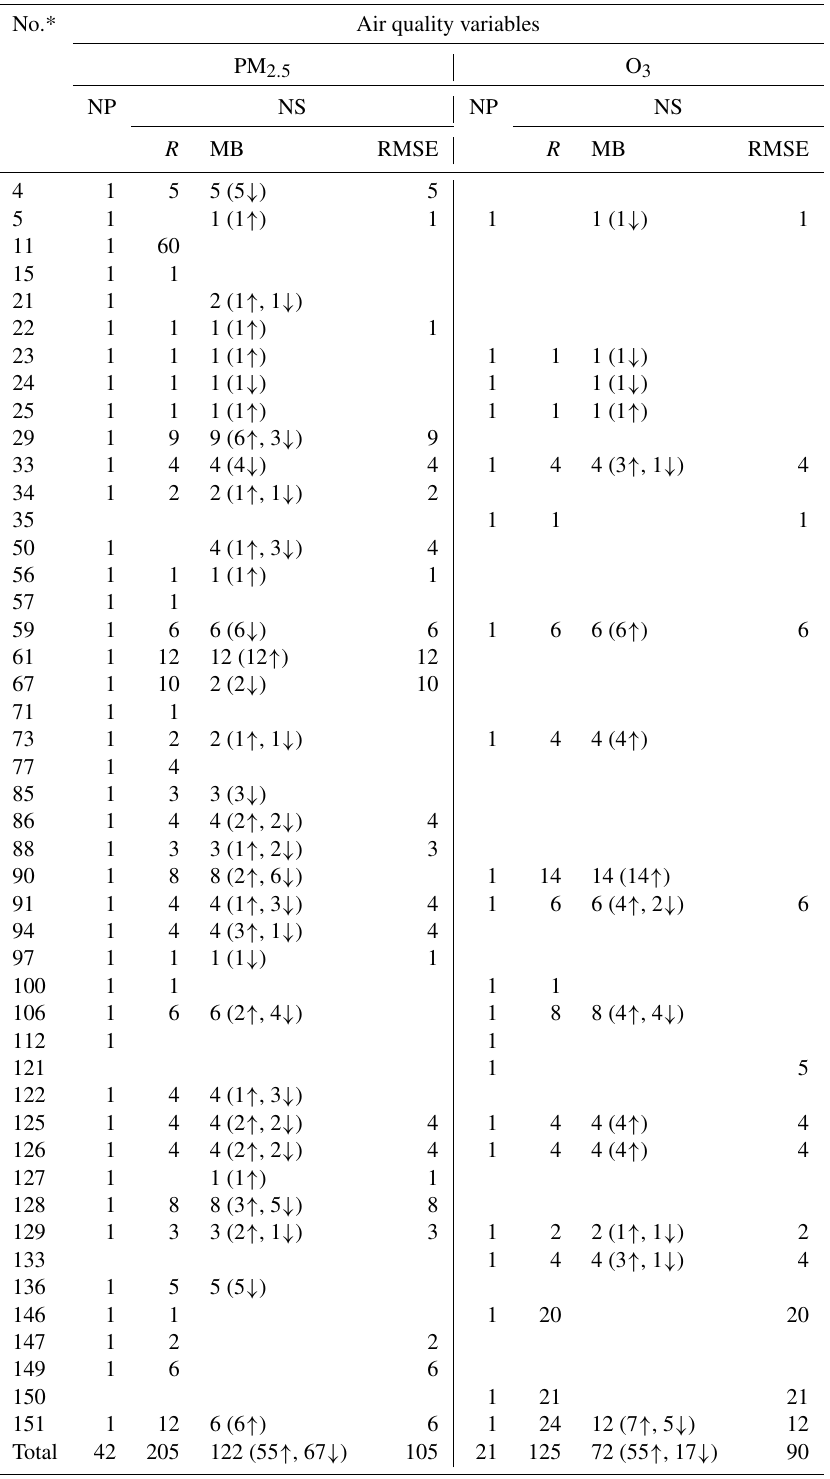
Table B3. The compiled number of publications (NP) and number of samples (NS) for papers providing statistical indices (SIs) of air quality